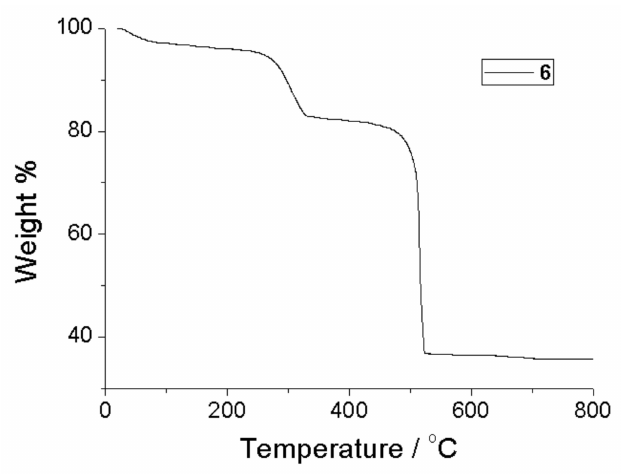
Figure 4. The TGA curve of compound 6